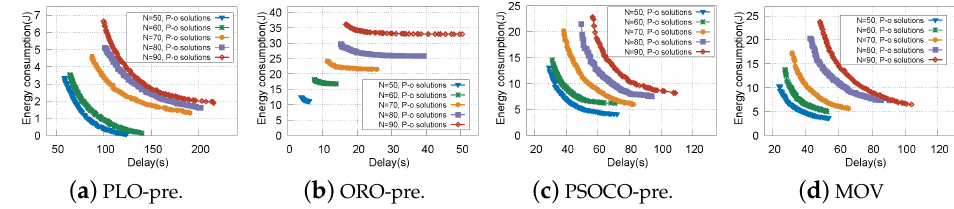
Figure 5. Pareto-optimal solutions under different